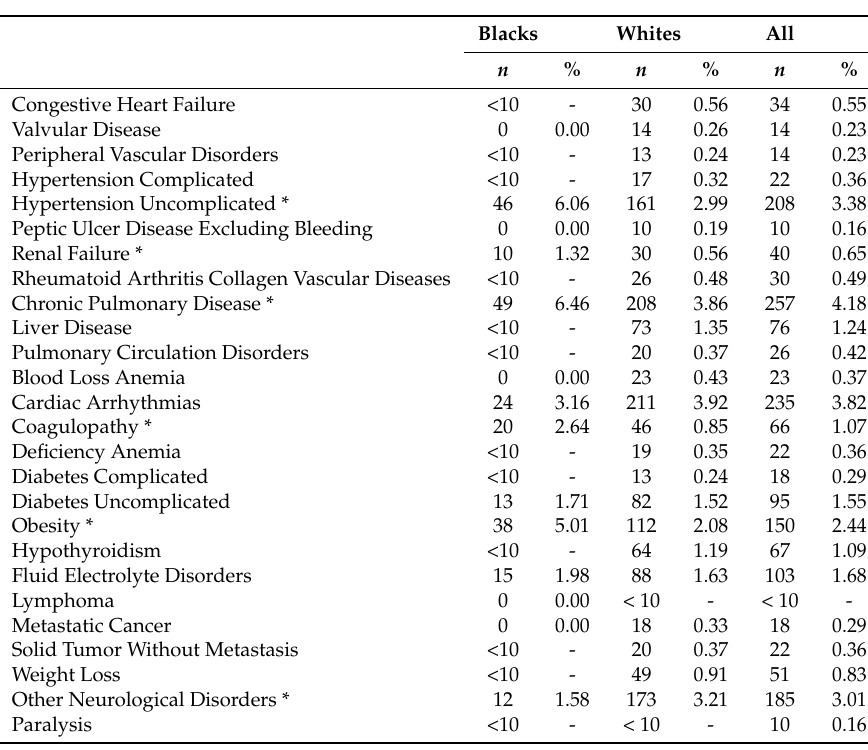
Table 4. Medical comorbidities in Blacks ( n = 759) and Whites ( n = 5388) with suicidal